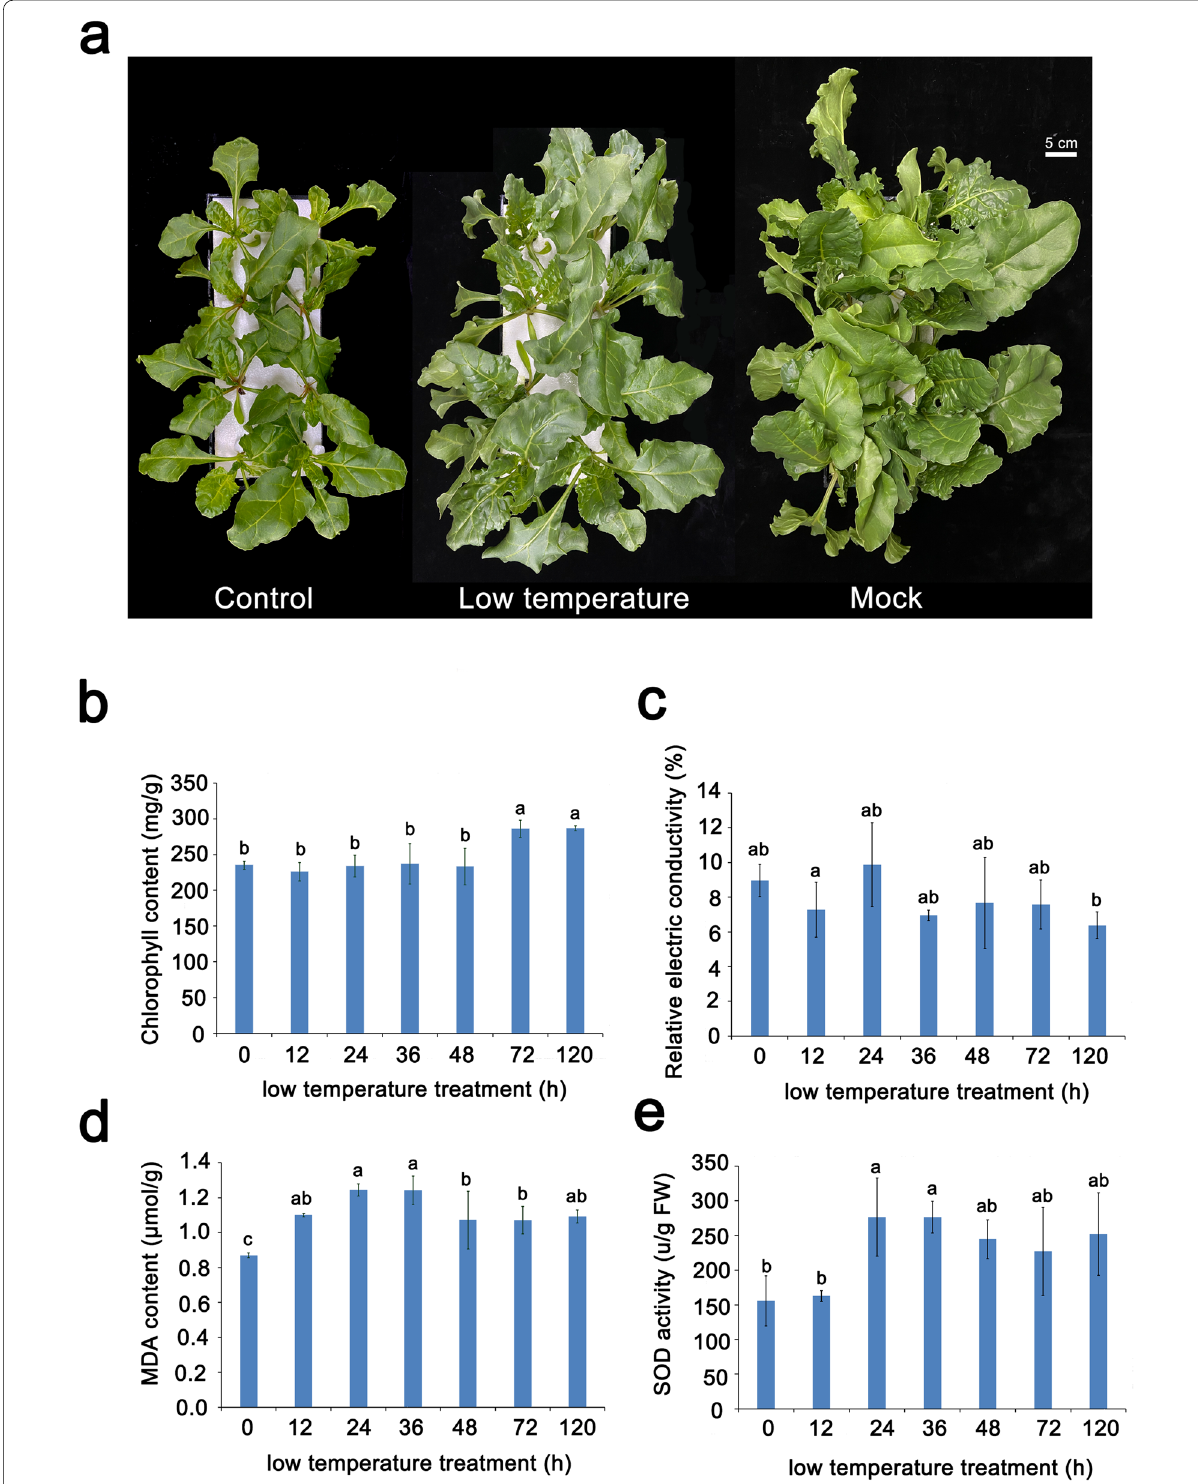
Fig. 1 Morphological and physiological changes of sugar beet. a The phenotype of sugar beet treated with and without low temperature (4 °C). The graph of control was taken at 0 h after chilling. The graph of low temperature was taken at 120 h after chilling. The graph of mock was taken at 120 h without chilling. b Effect of low temperature (4 °C) on chlorophyll, c relative electrical conductivity (REL), d malondialdehyde (MDA), e superoxide dismutase (SOD) in sugar beet. Lowercase letters represent the significant level of P < 0.05 between different